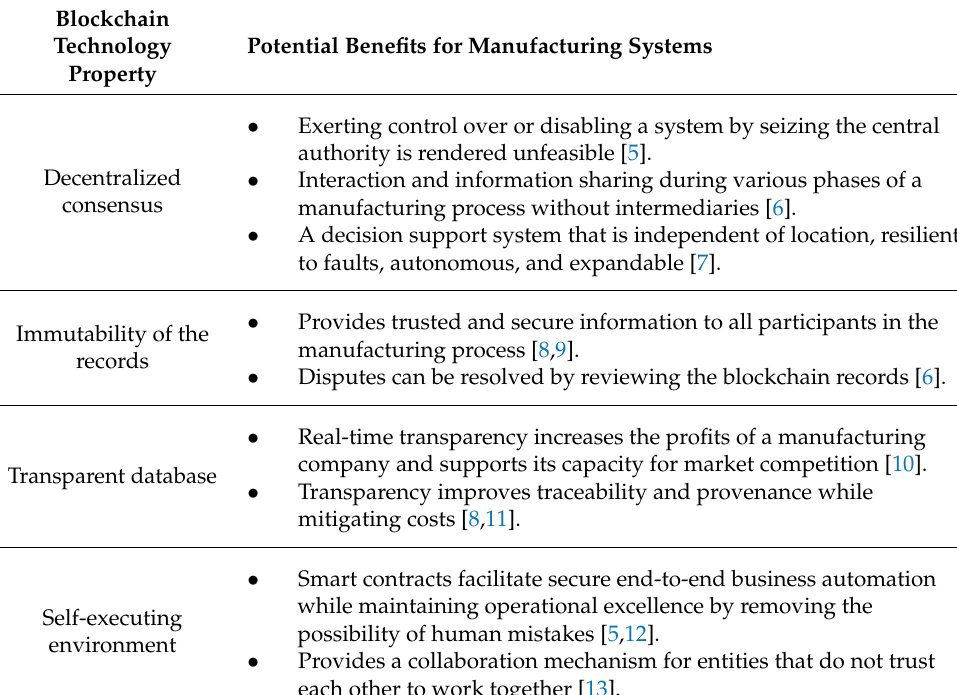
Table 1. Potential benefits of blockchain technology for manufacturing